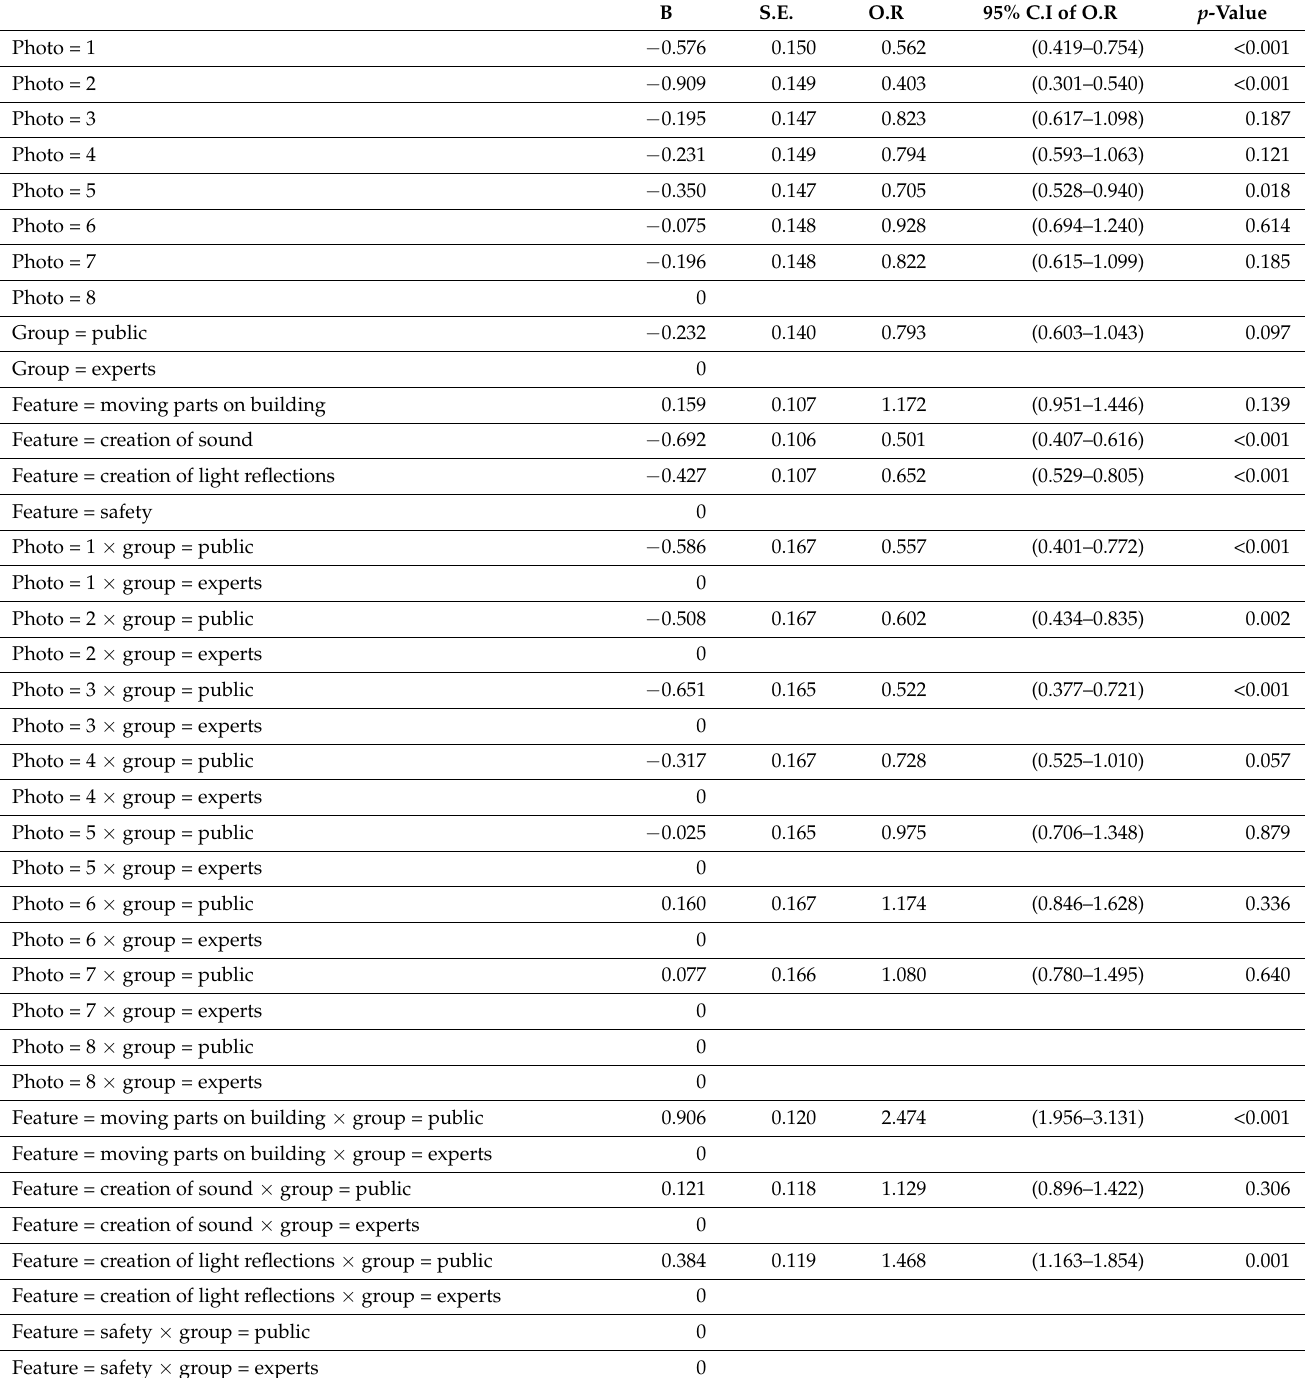
Table 17. Parameter estimates, standard errors, odds ratios and 95% confidence